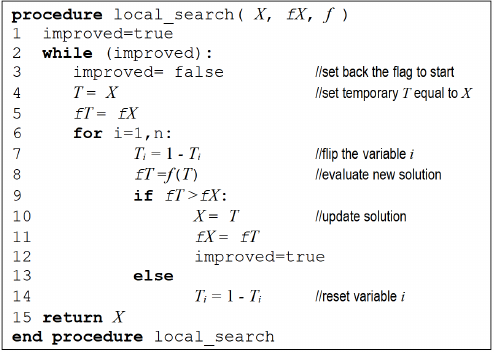
Figure 4. Local search for QUBO